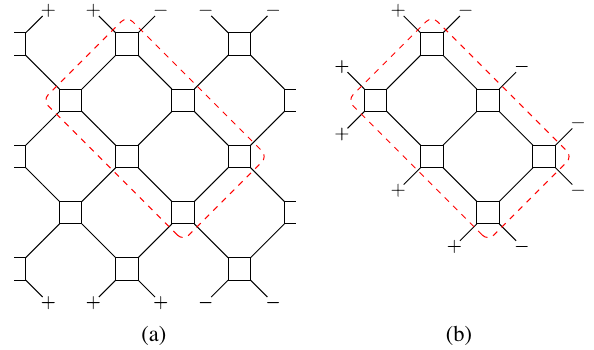
x; t Þ for a dual-unitary FIG. 13. The partition function Z op ð x ¼ 1 ; t ¼ 5 Þ . By unitarity [the first identity in circuit. (a) q 2 L Z op ð Eq. (98)], we can remove the unitaries outside the light cone, x ¼ 1 ; t ¼ 5 Þ as expression (b). Then, Eq. (98) giving q 2 t Z op ð allows the remaining gates to be removed.